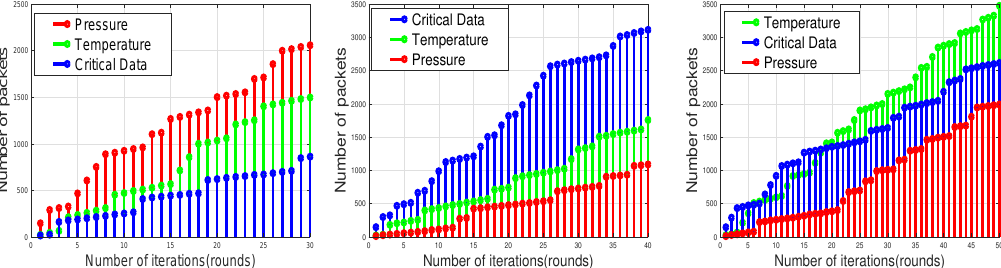
Figure 6. Direct transmission of critical data in SADFIR routing